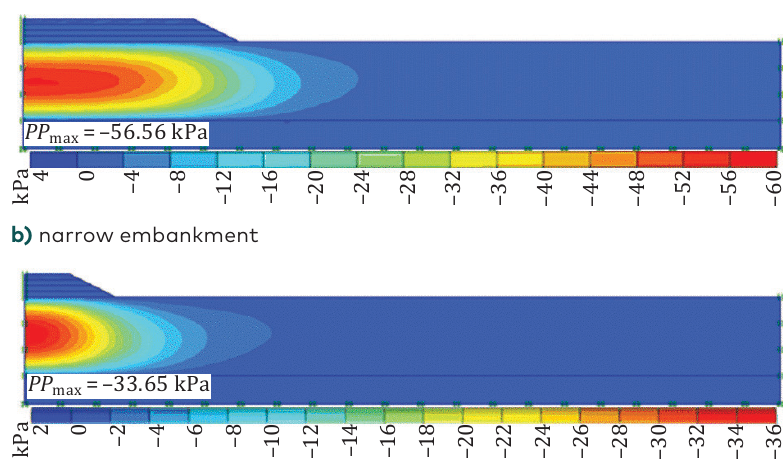
Figure 10. Distribution of excess pore pressure